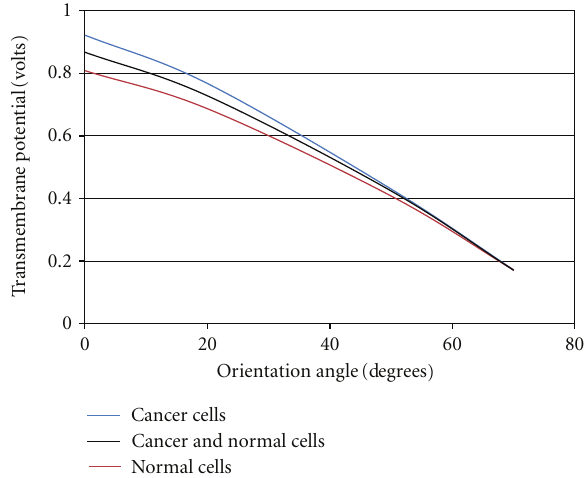
Figure 10: Variation of transmembrane potential with